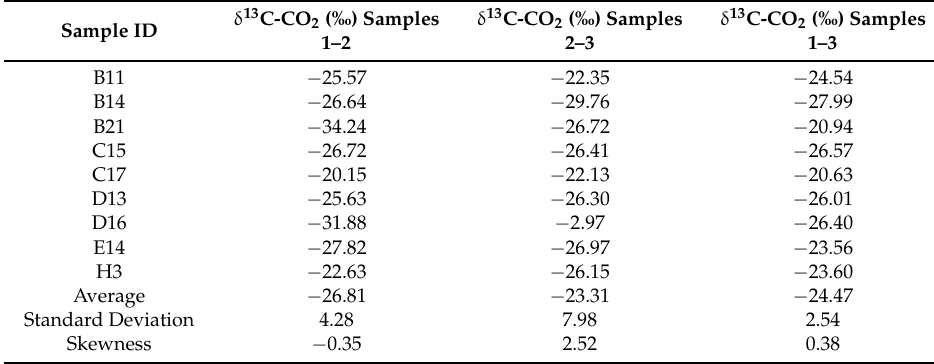
Table 2. Isotope ratio results using Keeling plot and adjusted for preferential